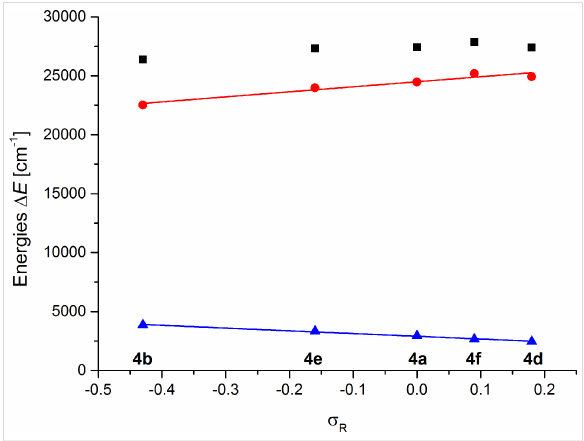
Figure 7: Hammett–Taft correlations of the emission maxima (red circles, l max,em = 4274 · s R + 24495 [cm − 1 ], R 2 = 0.925) and Stokes shifts (blue triangles, Δ = − 2319 · s R + 2909 [cm − 1 ], R 2 = 0.989) of compounds 4a , b , d–f with s R (black squares are the corresponding absorption